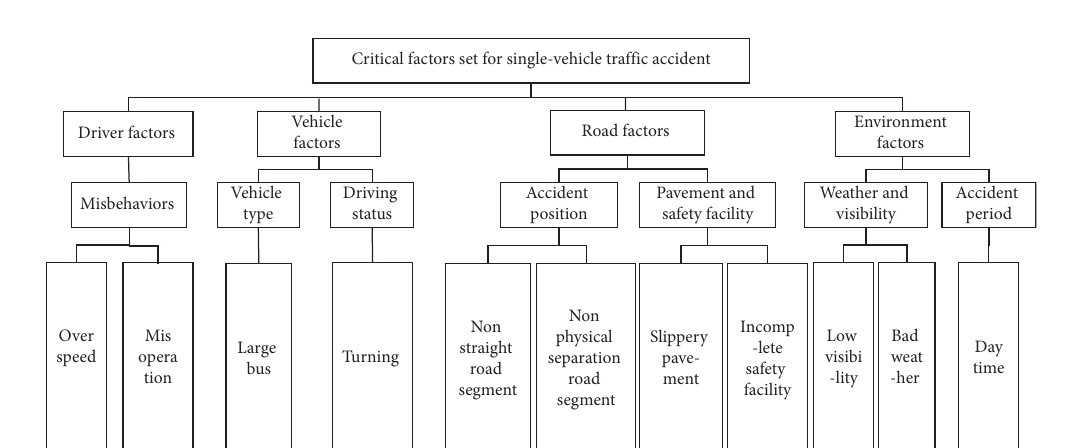
Figure 3: Critical factor set for the single-vehicle traffic